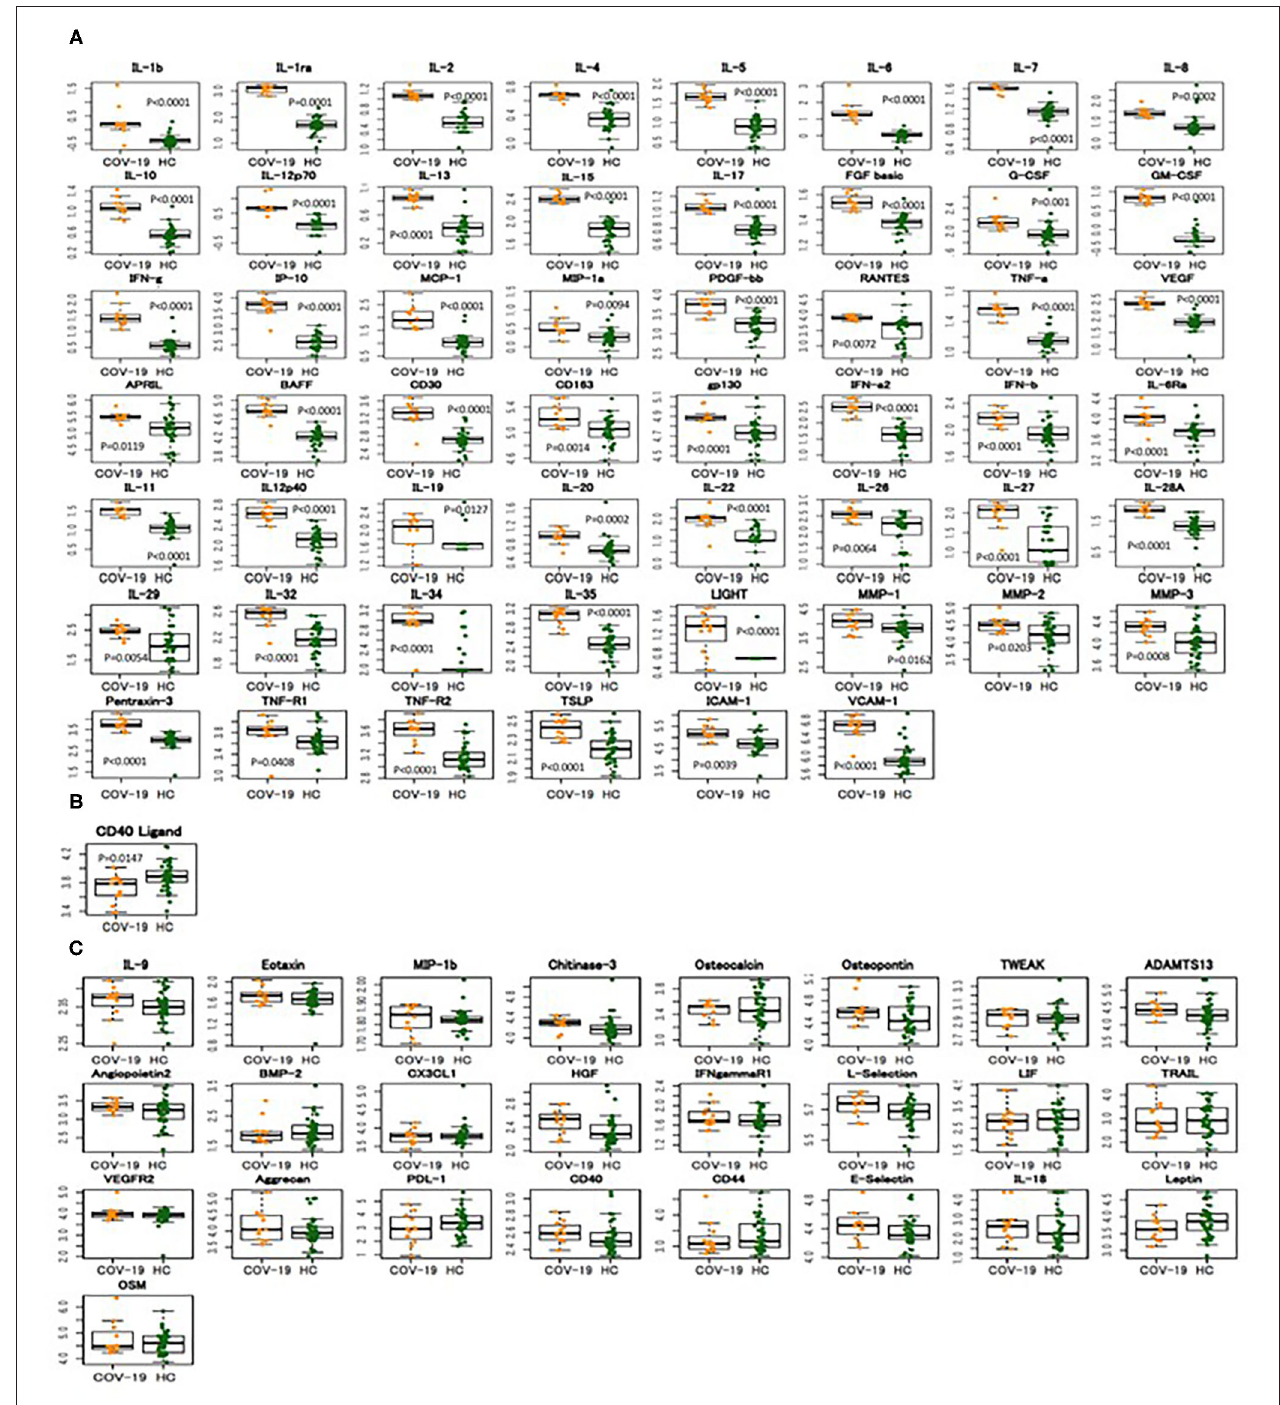
FIGURE 2 | Widespread increase in biomediator levels in severely to critically ill patients with COVID-19. Expression of 80 biomediators in the sera of 12 patients with severely to critically ill patients with COVID-19 (COV-19) and 38 healthy controls (HC) was measured using a multiplex cytokine array system. The boxplots show medians (middle line) with first and third quartiles (boxes), while the whiskers show 1.5x the interquartile range (IQR) above and below the box. (A) Increased biomediators in COVID-19, (B) decreased biomediators in COVID-19, (C) no difference in serum levels of biomediators between COVID-19 and healthy controls.